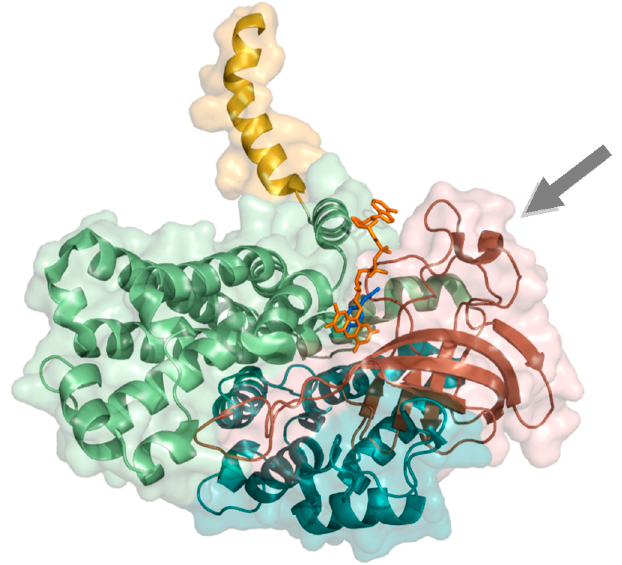
Figure 4. Structure of 4-hydroxyphenylacetate 3-hydroxylase (HPAH) monomer (PDB ID: 2YYJ). Coloring is according to the N -terminal domain (teal), middle domain (brown), the C -terminal domain (pale green), and the C -terminal tail (yellow). The surface is indicated transparently, FAD (orange) and 4-hydroxyphenylacetate (blue). The loop region that allows recognition of the adenine moiety of FAD is indicated by an arrow.